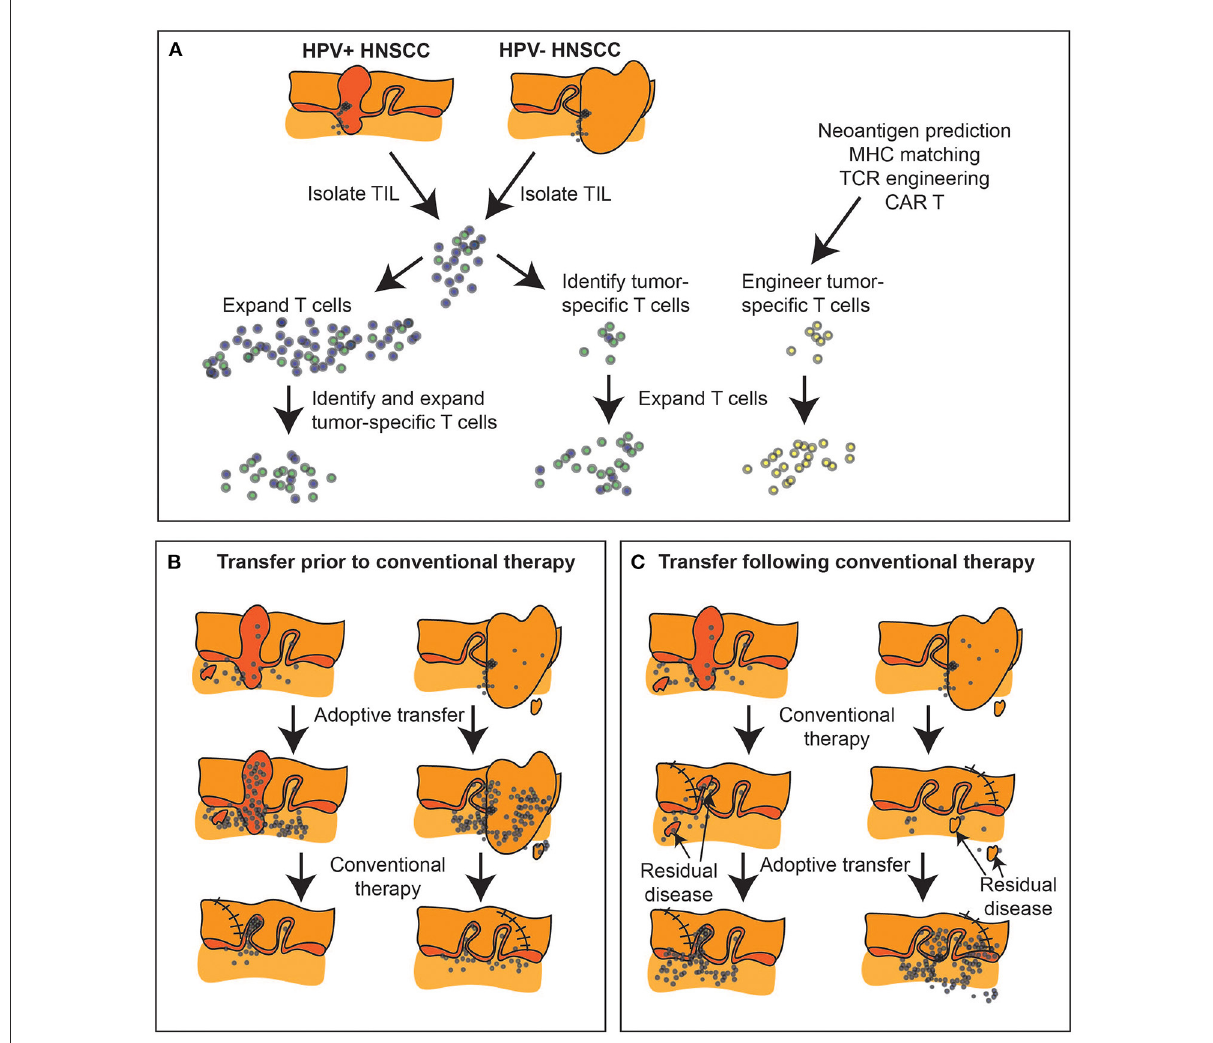
FIGURE4 Expanding tumor-specific T cell immunity via adoptive transfer. (A) Biopsies and surgical specimen can be a source of tumor infiltrating lymphocytes (TIL), which can be expanded ex vivo and tumor-specific cells isolated either by response, or by initial phenotype. Alternatively, tumor-specific T cells can be engineered if both antigen and MHC match known TCR specificities, or using chimeric antigen receptors (CAR). (B) Adoptive transfer can occur prior to conventional therapy to alter the tumor immune environment prior to further treatment, or (C) can follow conventional therapy to target residual disease. At present, with surgical samples the dominant source of TIL, adoptive transfer is generally delivered following completion of conventional multimodality treatment or in the metastatic setting.